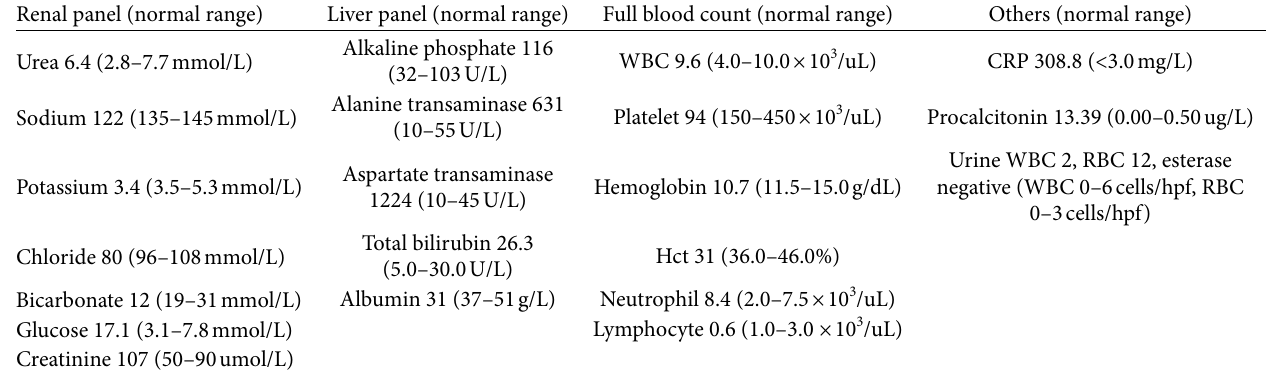
Table 1: Lab values for the patient.